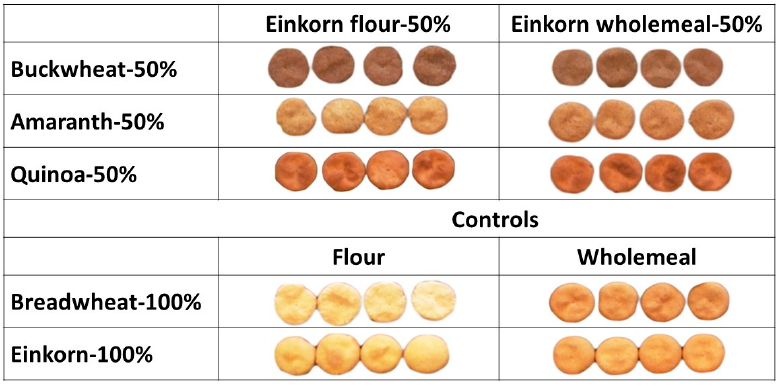
Figure 4. Water biscuits prepared with 50% einkorn flour and 50% buckwheat, amaranth, or quinoa wholemeal, or 100% bread wheat flour or 100% einkorn flour (on the left ) and water biscuits prepared with 50% einkorn wholemeal and 50% buckwheat, amaranth, or quinoa wholemeal, or 100% bread wheat wholemeal or 100% einkorn wholemeal (on the right ).